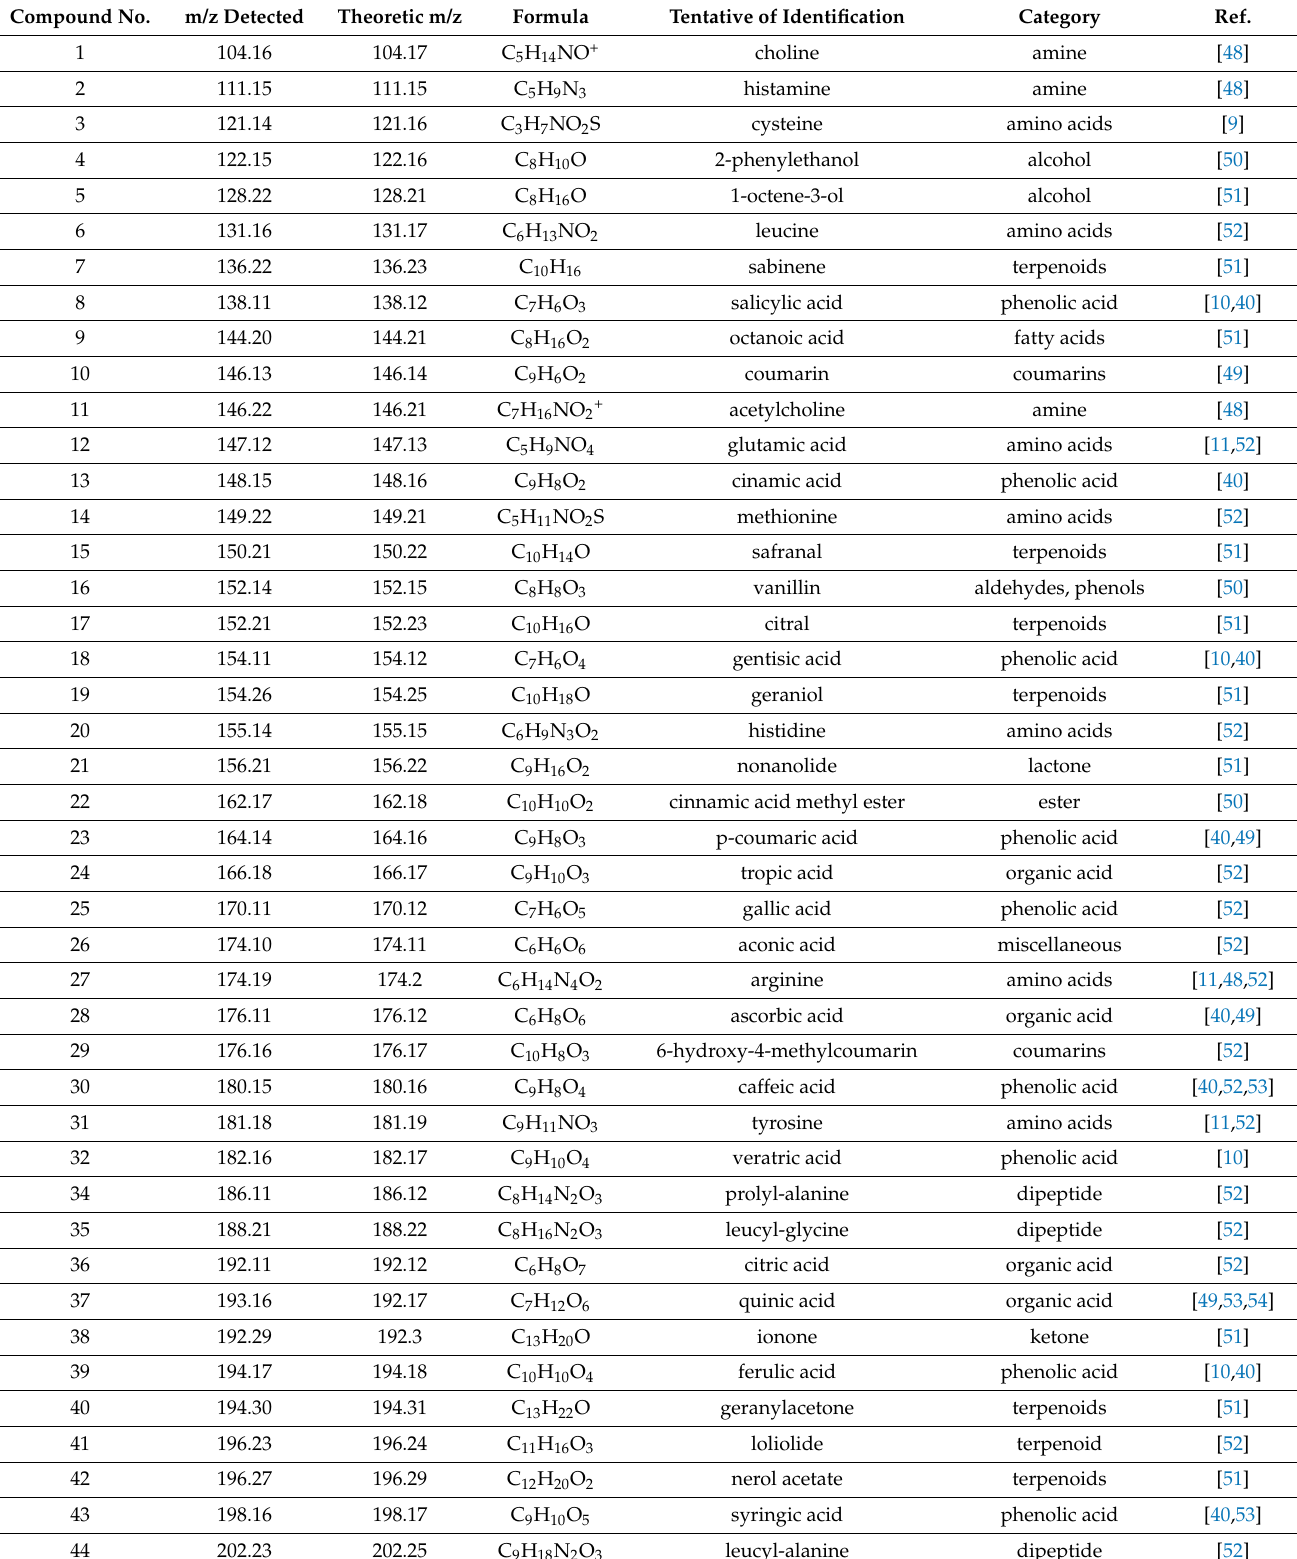
Table 1. Components identified through electrospray ionization–quadrupole time-of-flight mass spectrometry (ESI-QTOF-MS)